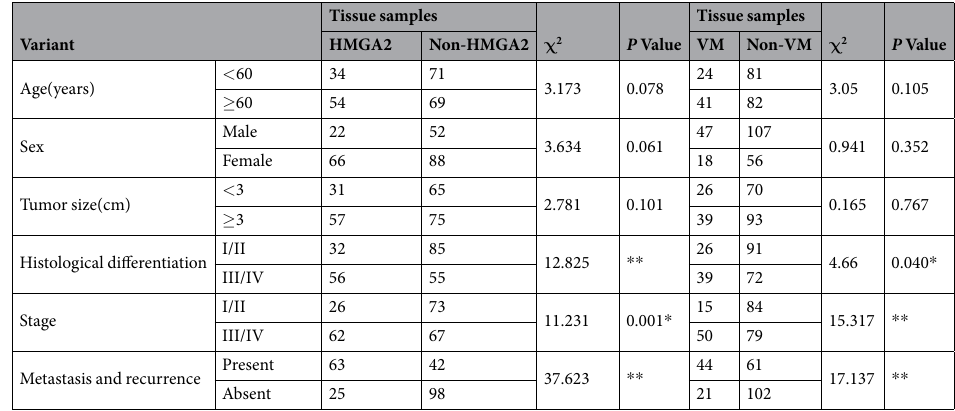
Table 1. The correlation of HMGA2 and VM with the clinicopathological parameter of gastric carcinoma. * P < 0.05, ** P < 0.001.